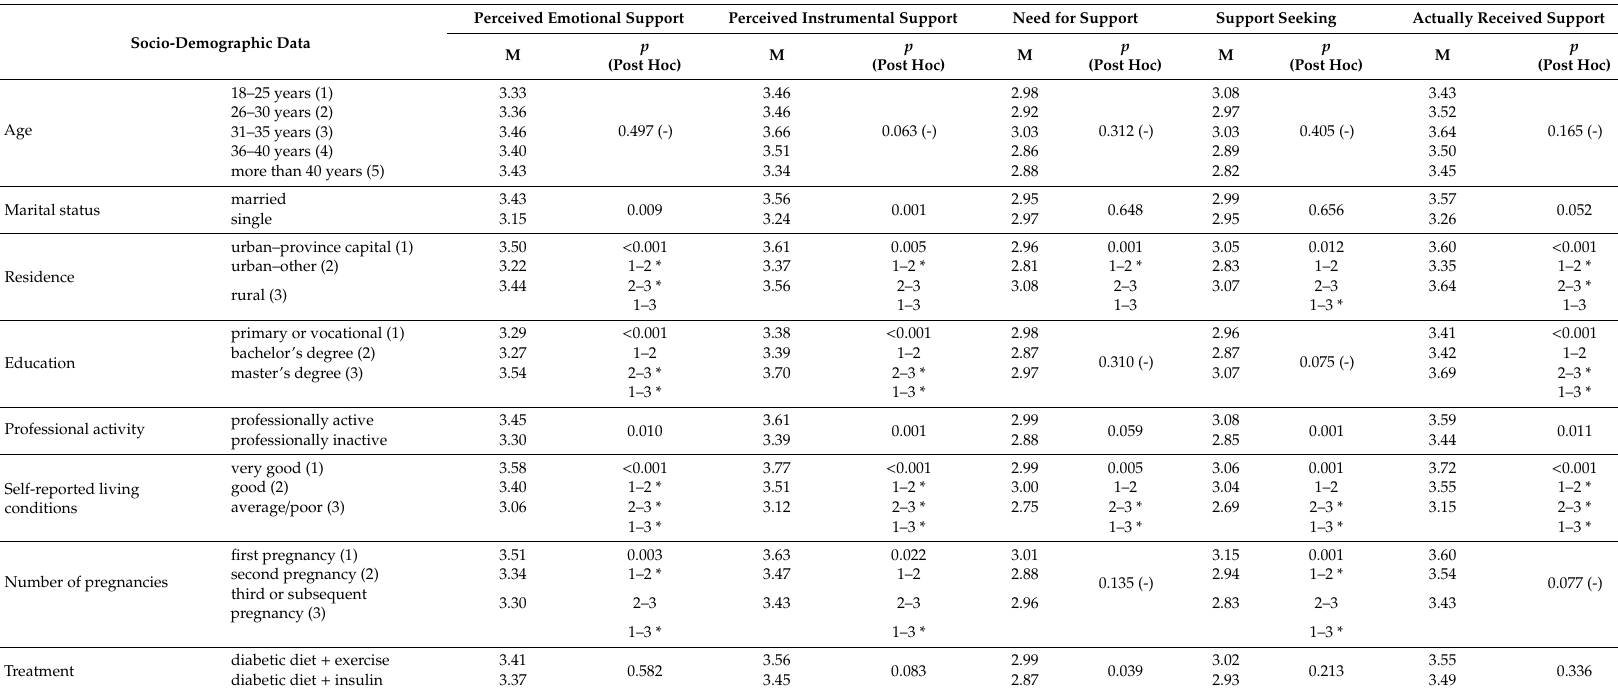
Table 5. Analysis of correlations between social support scores (BSSS) and socio-demographic variables among pregnant women with hyperglycemia. Socio-Demographic Data